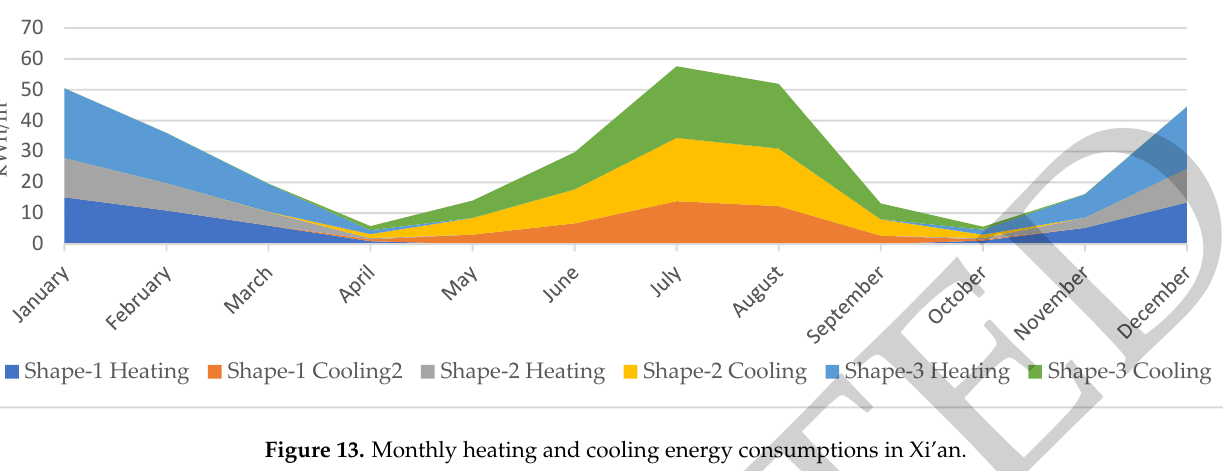
Figure 13. Monthly heating and cooling energy consumptions in Xi’an.